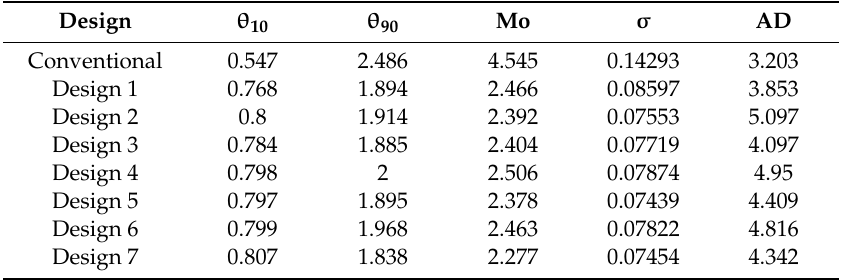
Table 4. Hydraulic and mixing e ffi ciency indexes for conventional and perforated ba ffl e designs.